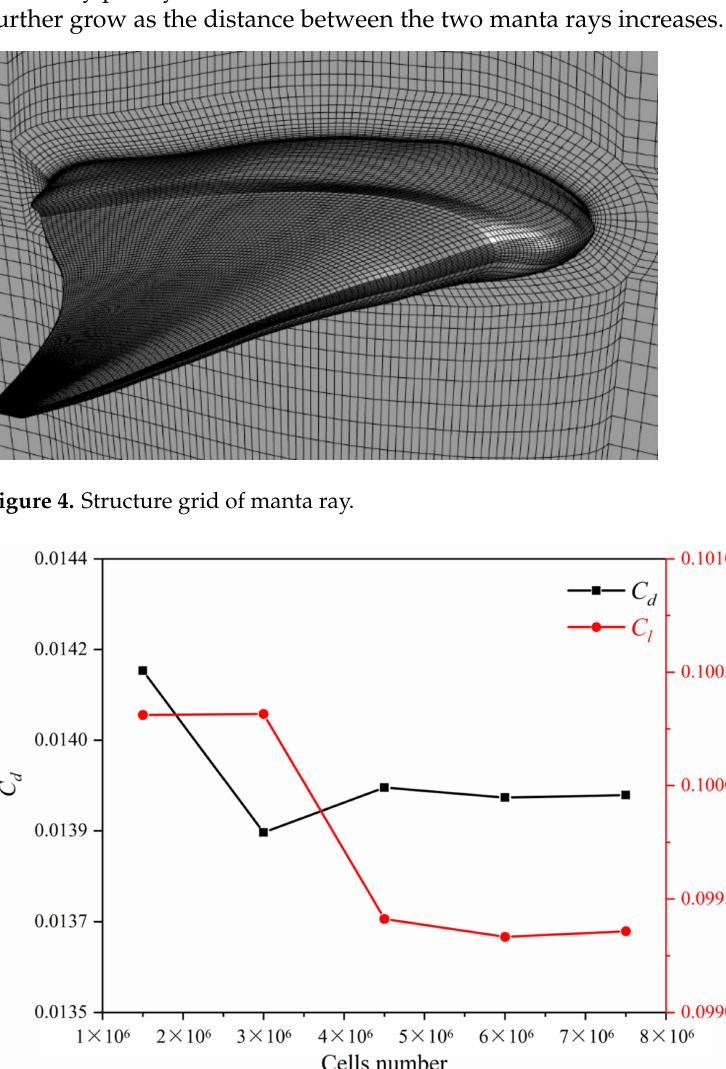
Figure 5. Simulation results under different numbers of